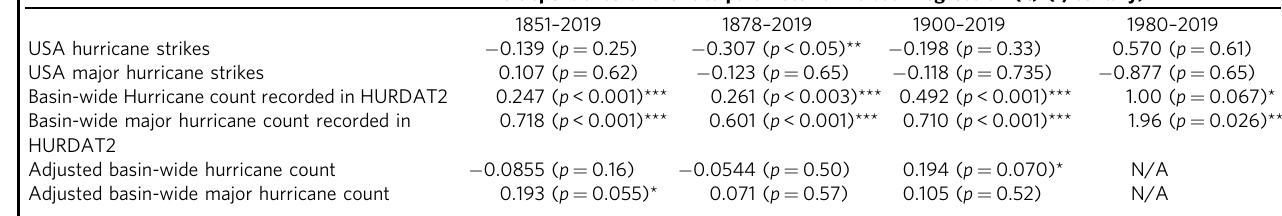
Trends in hurricane frequency measures over four different time periods, based on a Poisson regression to hurricane and major hurricane frequency with time as a covariate (see “ Methods ” ); values are the time-dependent part of the rate parameter for a Poisson regression (see “ Methods ” ). Counts are based on data from version 2 of the North Atlantic Hurricane Database (HURDAT2, ref. 33 ) and the adjustmentdevelopedinthisstudy.Valueswitha p- valuelessthan0.1arehighlightedbyasingleasterisk(*),witha p- valuelessthan0.05byadoubleasterisk(**),andlessthan0.01byatripleasterisk (***). We show four time periods because of key observing system inhomogeneities: 1851 – 1877 is the period before the U.S. Signal Corps was tasked with recording all tropical cyclones in the North Atlantic (ref. 35 ), 1900 is the time after which it is estimated that all hurricanes striking the United States of America (USA) would have been recorded (ref. 36 ), and homogenized satellite-based TC intensity data are available since 1980 (ref. 14